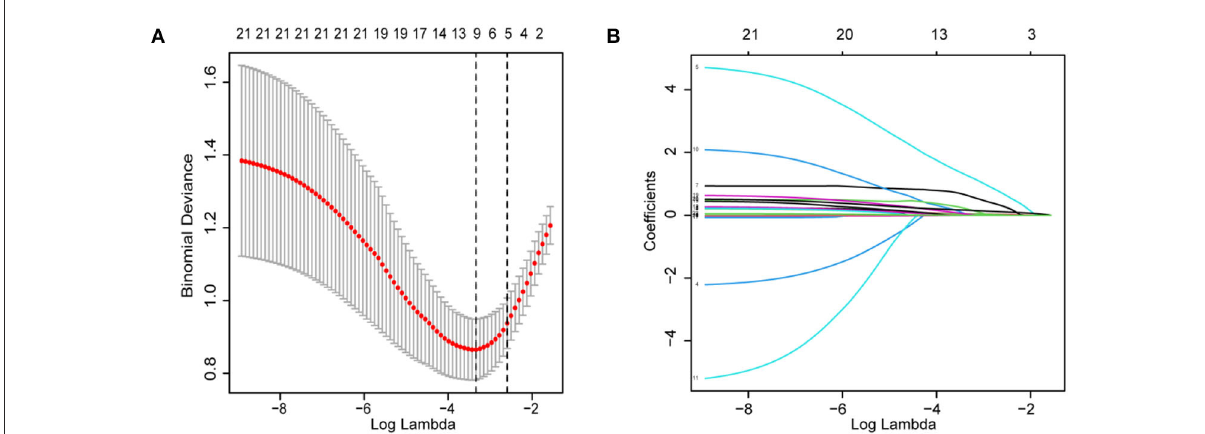
FIGURE1 Demographics, clinical characteristics, vascular risk factors, and laboratory outcomes were selected using the LASSO binary logistic regression model. (A) In LASSO regression, the adjustment parameter (lambda) for bias was chosen based on the minimum criterion (left dashed line) and the 1-SE criterion (right dashed line). The lambda value is 0.0750. (B) Coefficient profiles were created from the log(lambda) series. In this study, the choice of predictors was based on the 1-SE criterion (right dashed line). Among the best results are features with five nonzero coefficients. LASSO, least absolute shrinkage and selection operator; SE, standard error.